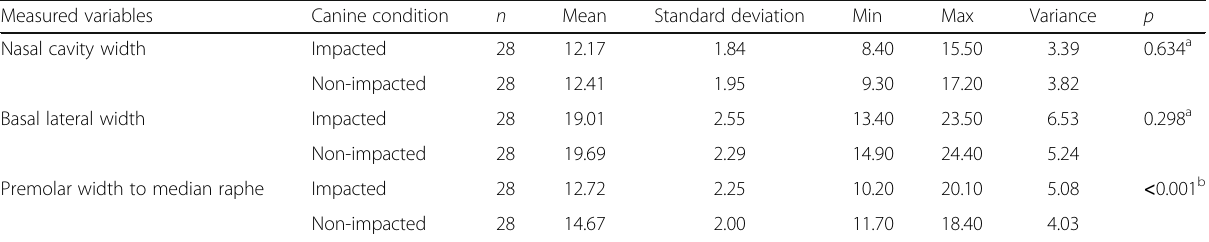
Table 4 Comparison of widths in bone and dentoalveolar dimensions of sample depending on the condition side of impaction Measured variables